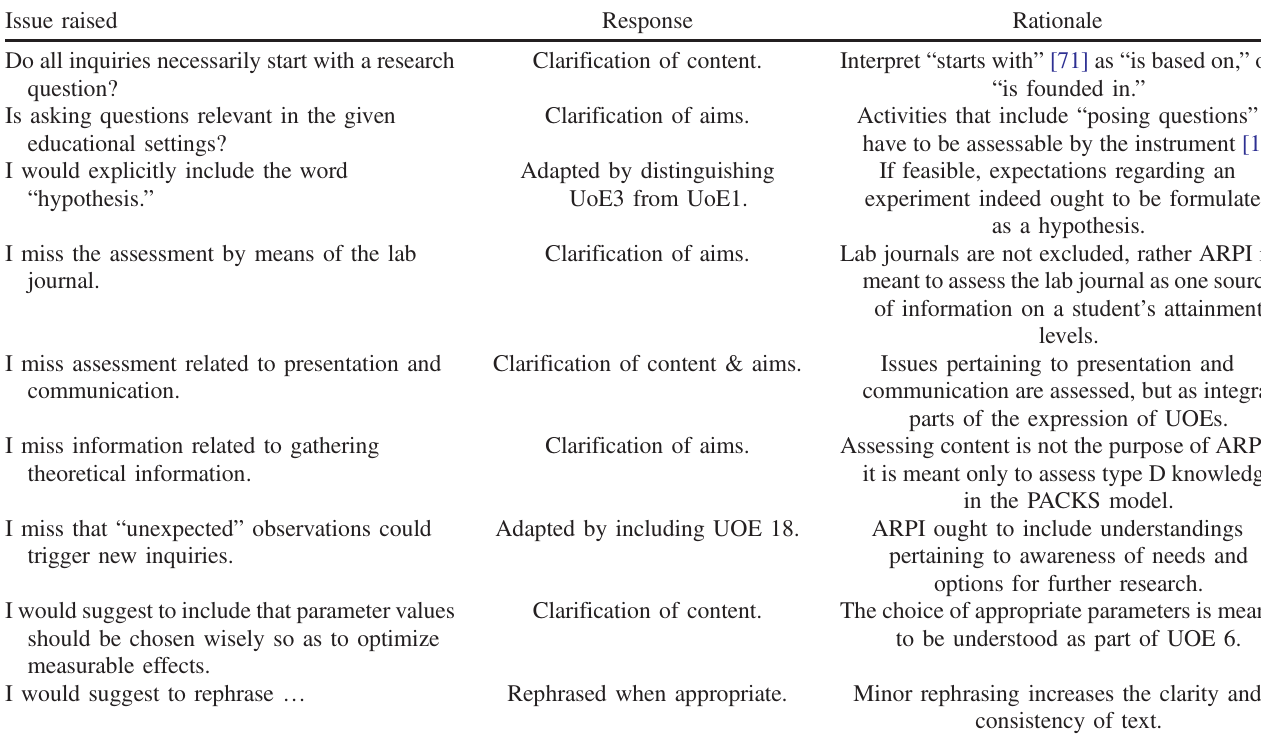
TABLE V. Issues raised by the experts in the second round along with our